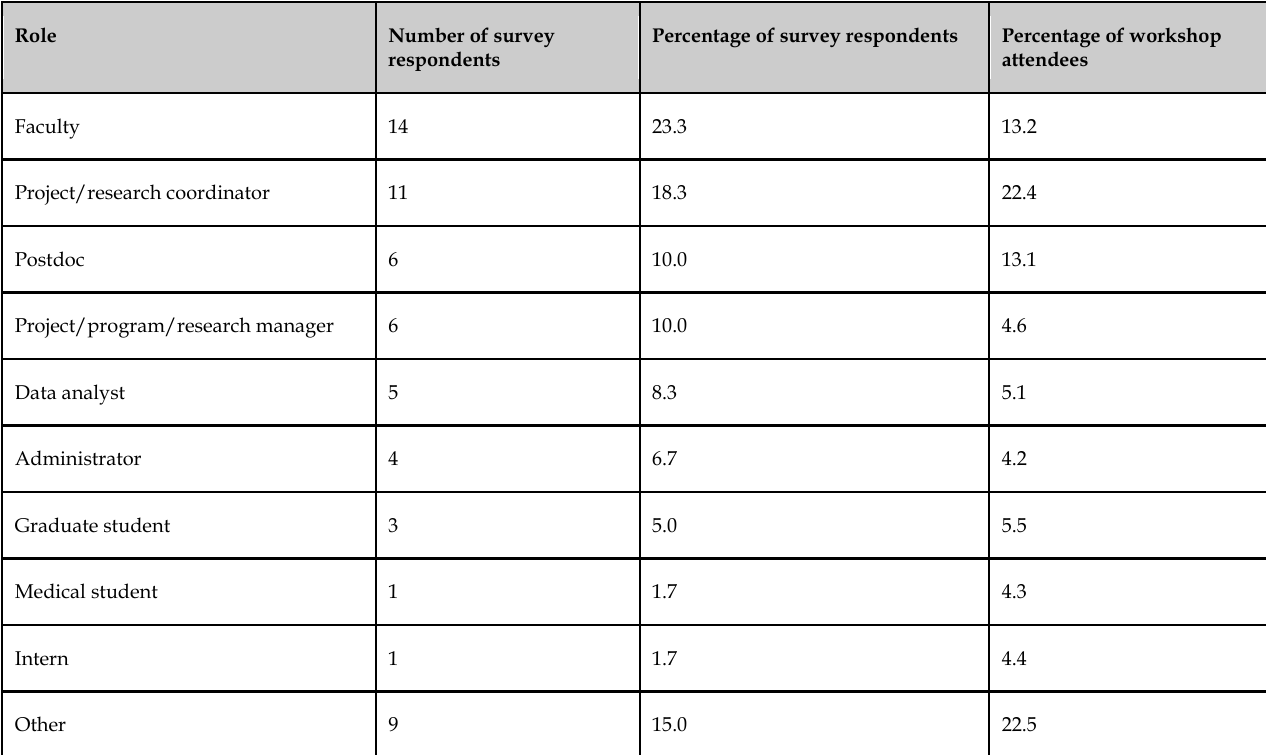
Table 2 Roles of survey respondents